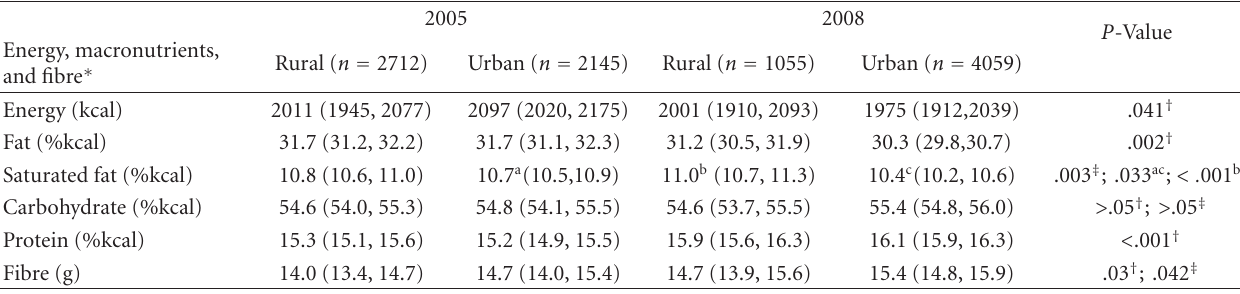
Table 1: Restricted maximum likelihood (REML) estimates of energy, macronutrient and fibre intakes of rural and urban Alberta students in 2005 and 2008 adjusted for SES, age, and